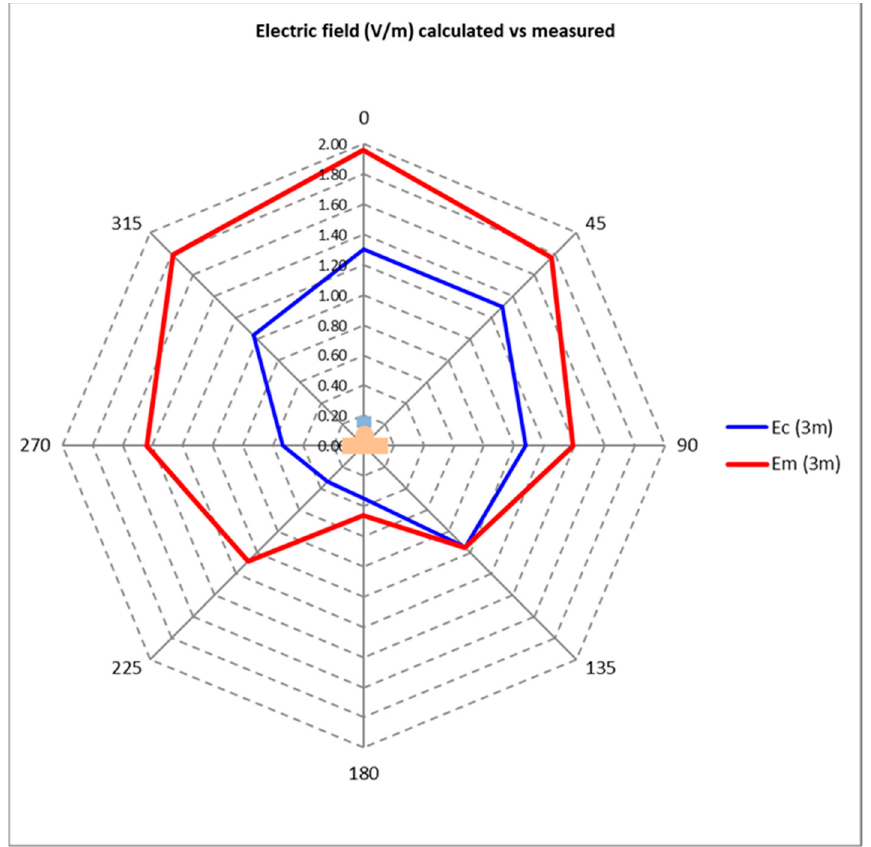
Figure 8. Spatial distribution of E-field measured and calculated near MO-RFID reader.